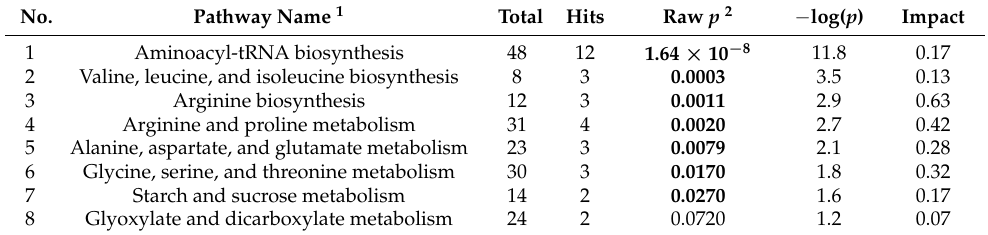
Table 2. Over-representation analysis (ORA) results for altered metabolites revealed in the compara- tive analysis of Drosophila species with different